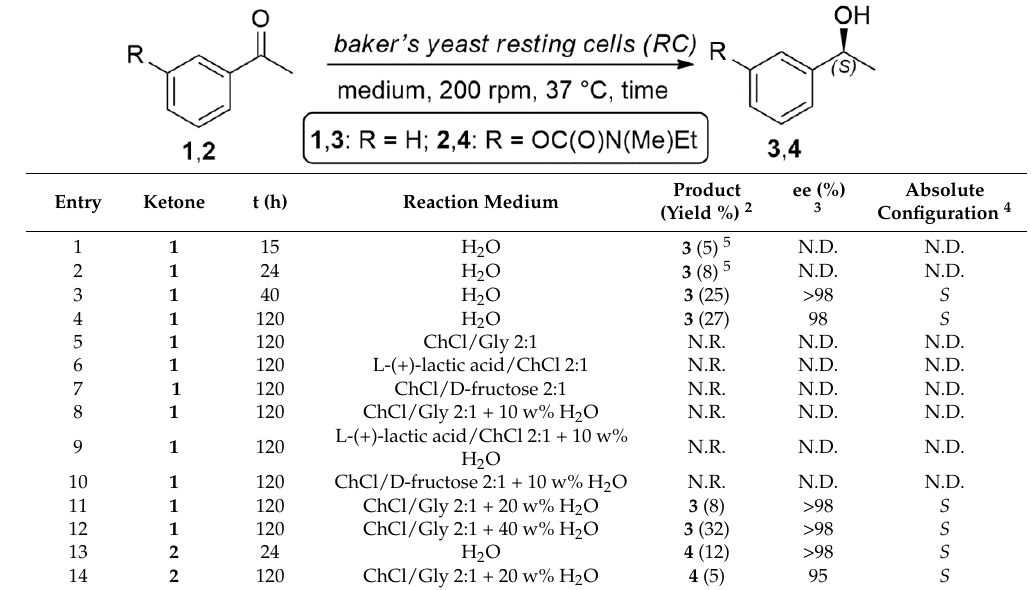
Table 1. Stereoselective bioreduction of ketones 1 and 2 with baker’s yeast RC in different reaction media. 1